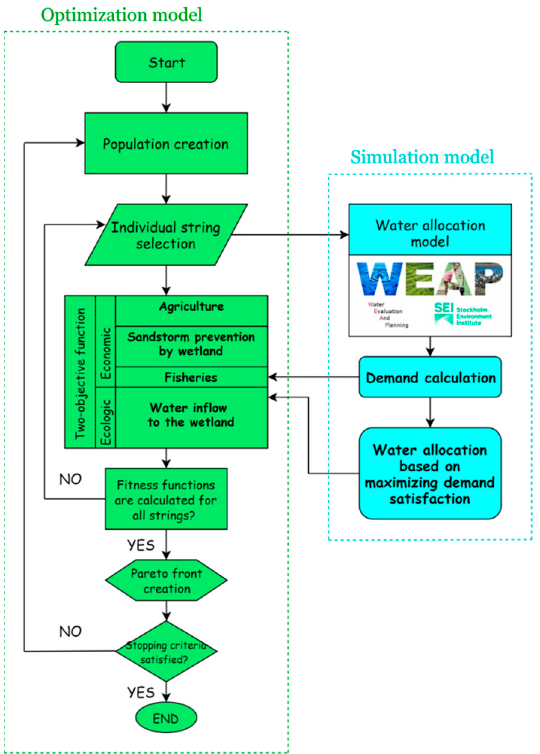
Figure 5. Schematic of the coupled simulation-based multi-objective optimization methodology.